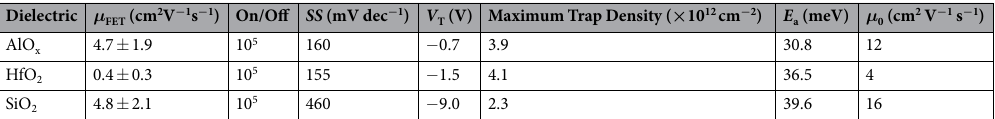
Table 1. Electrical performances, including μ FET (field-effect mobility), on/off ratio, SS (subthreshold swing), V T (threshold voltage), maximum trap density, E a (activation energy), and μ 0 (the trap-free mobility), of the OFETs with different